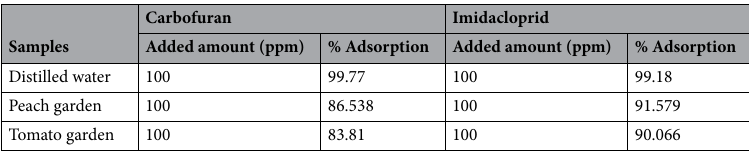
Adsorbent Adsorbate